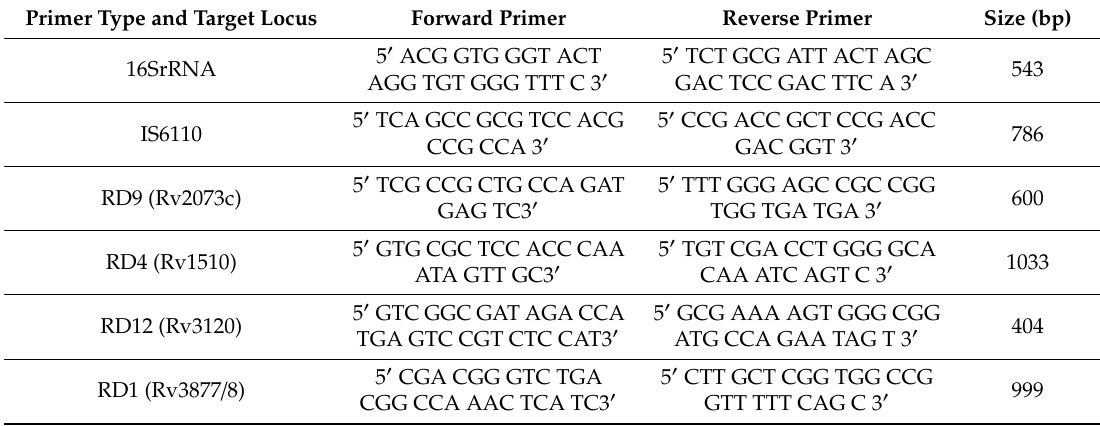
Table 1. Nucleotide sequence of primers used to determine the presence of Mycobacterium bovis [24,28]. Primer Type and Target